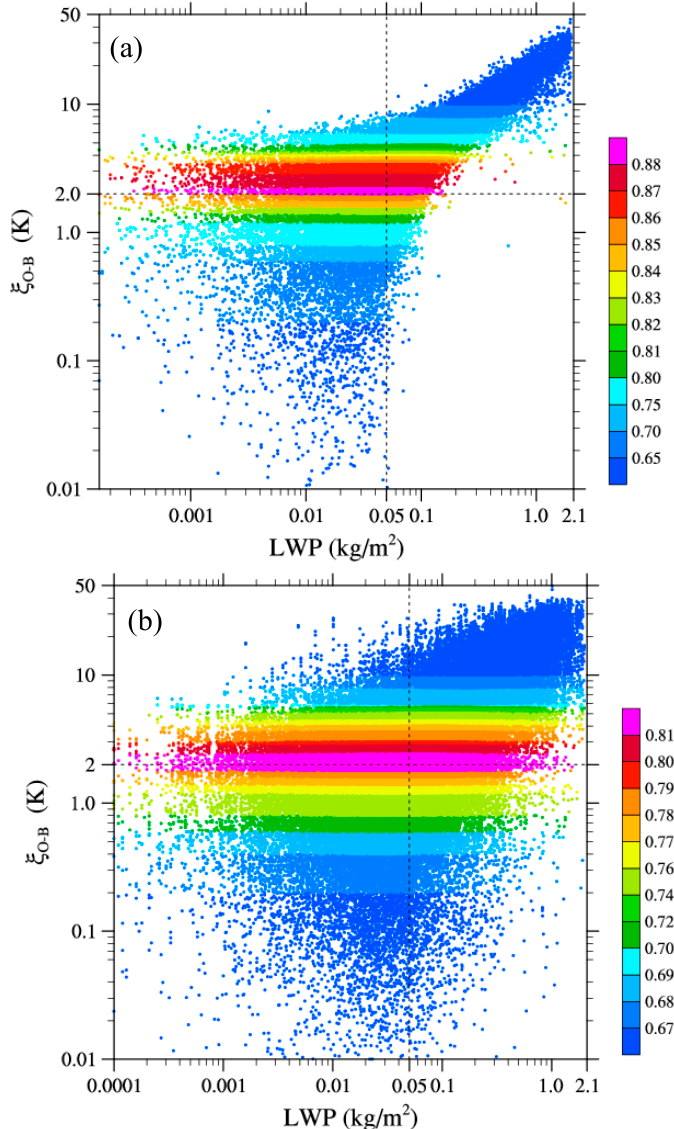
Figure 10. Scatterplots of ξ O − B versus LWP for ( a ) MetOp-B AMSU-A channel 3 and ( b ) FY-3C MWTS-2 channel 1 for data on 15 July 2014. Colors represent the values of the probability of correct typing at di ff erent thresholds (s) for ξ O − B ≤ s (interval: 0.2 K).